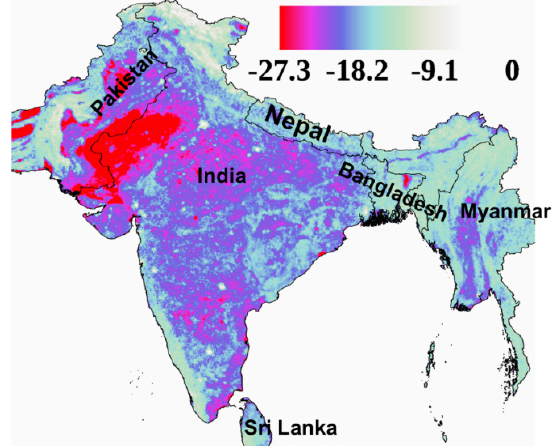
Figure 1. Sigma-0 from Ku band scatterometer of SCATSAT-1 in HH Polarization over the study area with the country boundary